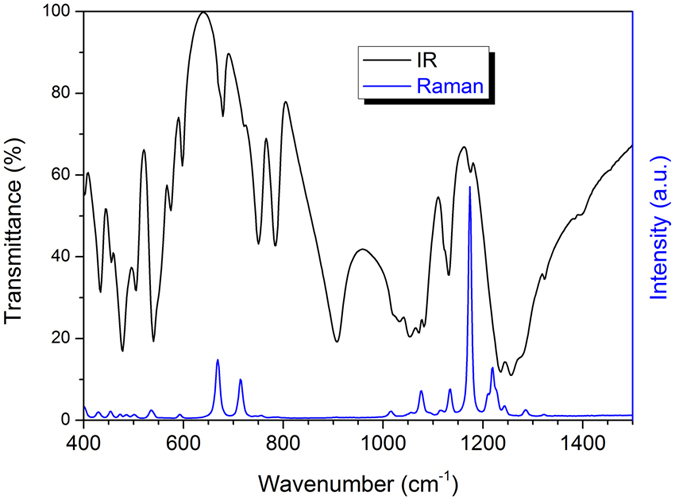
The IR and Raman spectra of KLa(PO3)4 at room temperature.